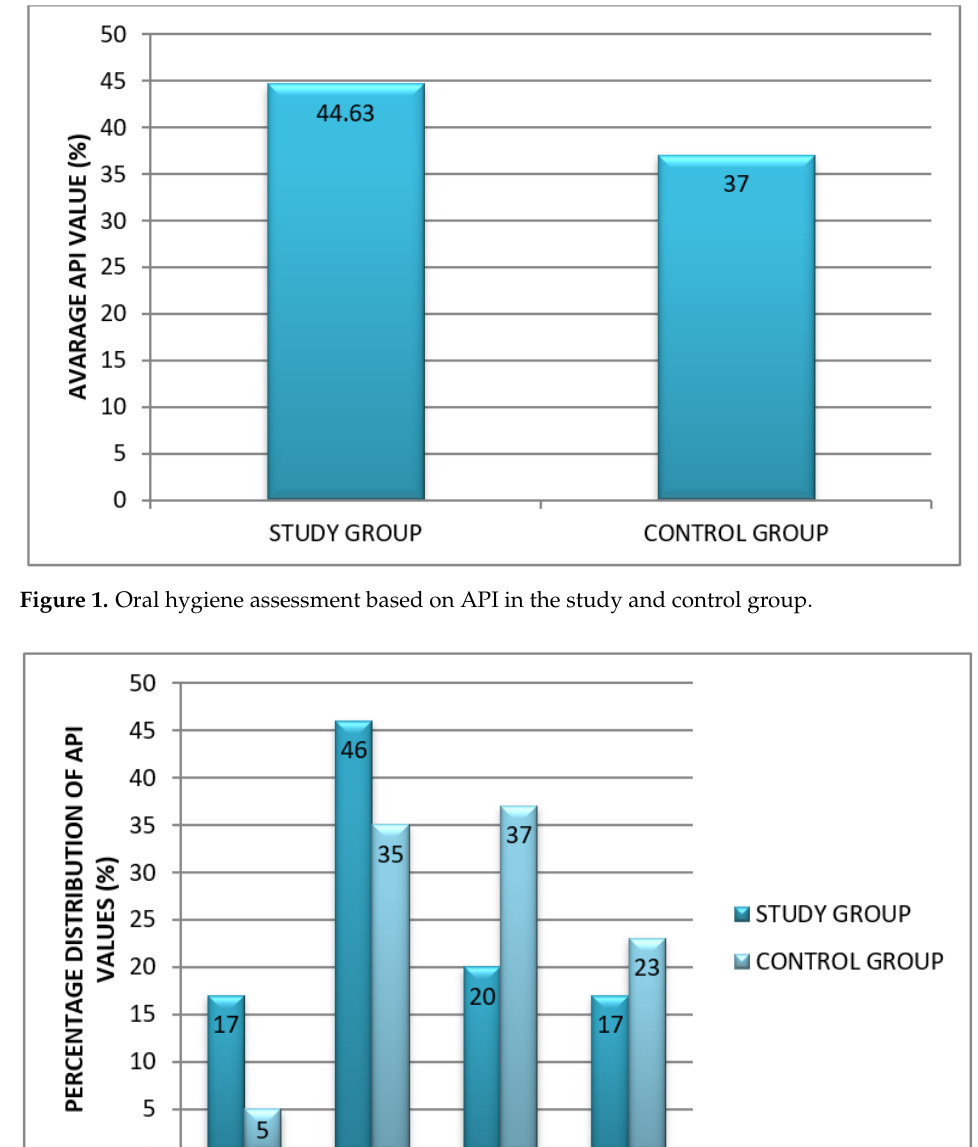
Figure 2. Interpretation of oral hygiene index (API) in both groups.